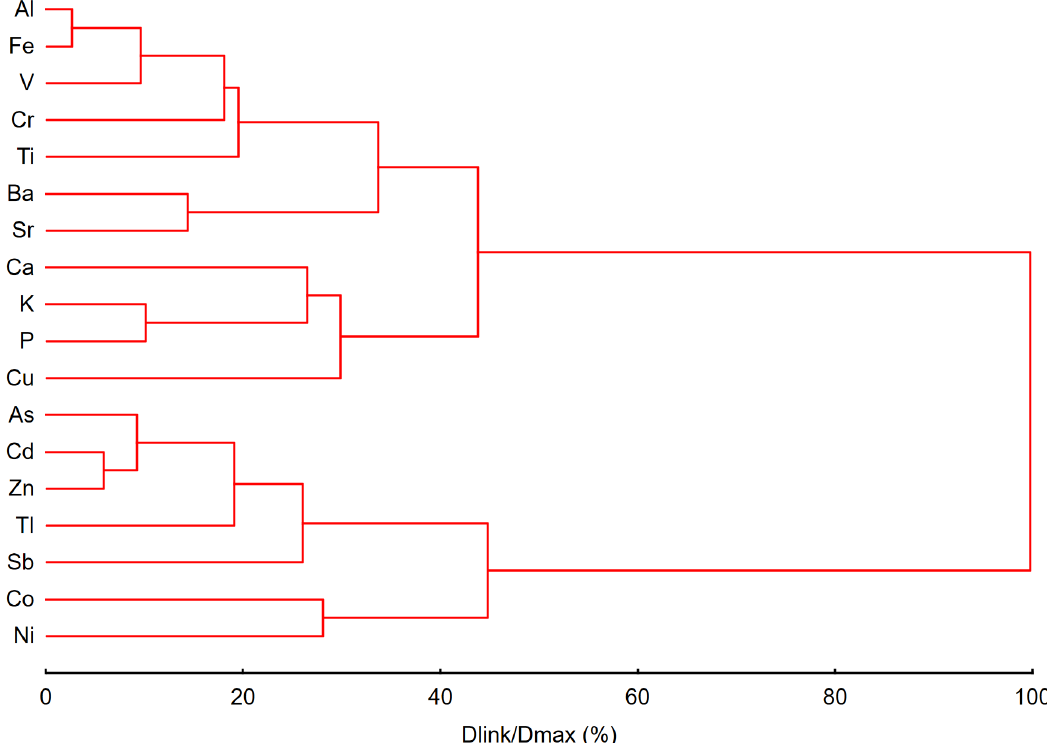
Figure 4. The hierarchical clustering elements measured in mosses samples. Elements which load most significantly in factor 2 are As, Cd, Sb, Tl and Zn. The dis- tribution map and the standard factor values according to districts and geology are shown in Figure 6. The element loading with the highest value is Zn and Sb load is the smallest of all. This is the second most important factor as it explains 21.4% of the total variance throughout the variables. In this group As, Cd and Zn are of anthropogenic origin as they are always associated with industrial activities [37,40,45]. However, it was found that Sb also co-exists with ores PbS and ZnS in the area of Trepça mines [46]. In a study performed in 2006 on the distribution of heavy metals in floodplain of agricultural soil along the Ibër River in the district of Mitrovica, almost the same group of elements was revealed by multivariate analysis [46]. These elements can be transported from this agricultural area by contributing to factor 2. As can be seen in the distribution map of factor values, the